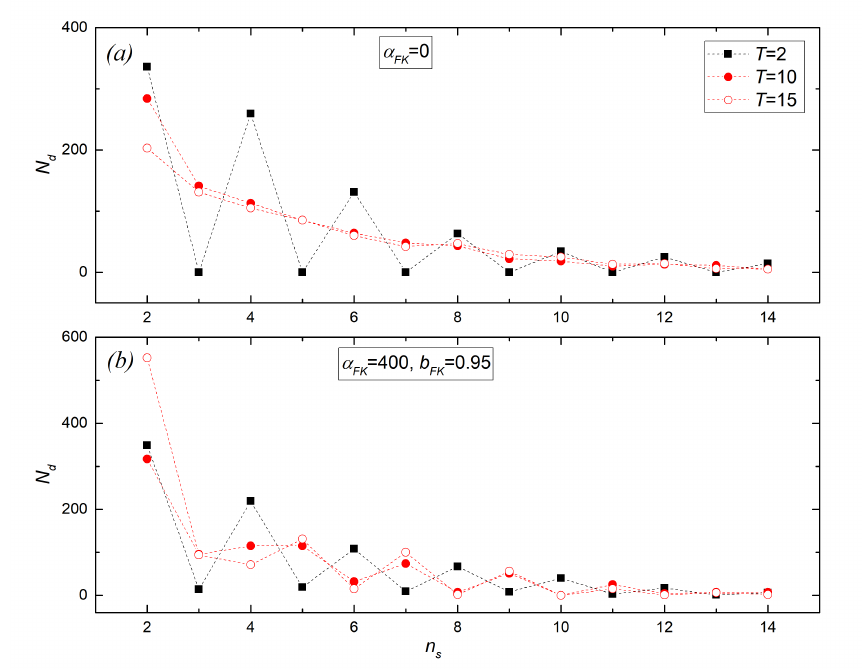
Figure 6. Number of magnetic domains at temperatures T = 2, 10, 15 ( a ) without the substrate potential and ( b ) in the presence of the substrate potential with an amplitude of 400 and a period of